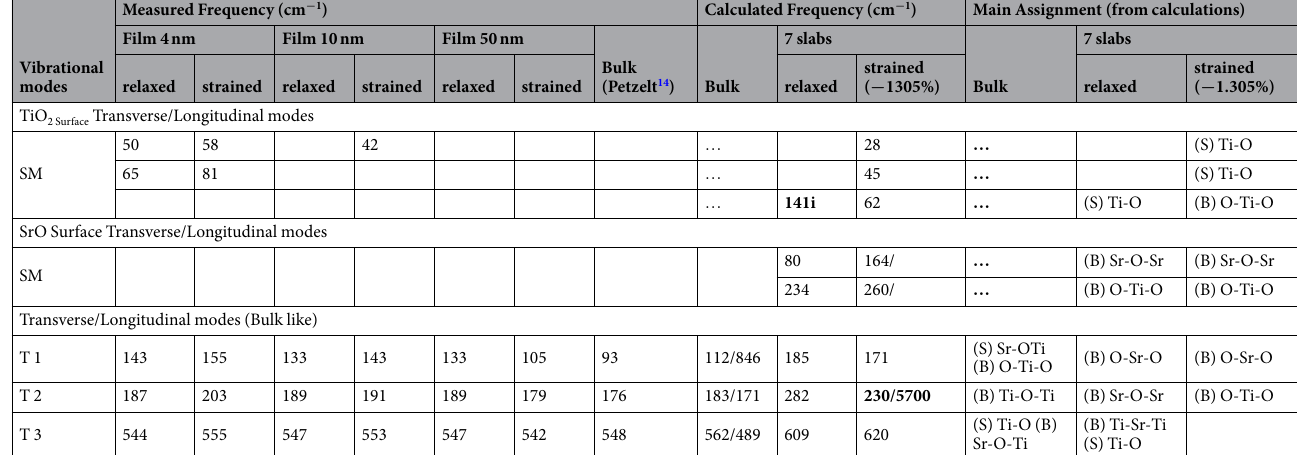
The unstrained and strained thickest films ( ∼ 50 nm) present the so-called TO 1 , TO 2 and TO 4 peaks as observed for bulk 13–15, 37 (See Table 1). For bulk modes, the assignments can be resumed as follows: TO 4 and TO 2 are Ti-O stretching and bending modes respectively, while the Sr-TiO 3 lattice vibration gives rise to TO 137 . Meanwhile, two weaker bands appear on the thinnest strained film at 58 and 81 cm − 1 and an intense band is clearly present on the strained 9 nm film at ~40 cm − 1 . In short, the strained thinner layers (5 and 9 nm) present phonons struc- tures shifted at higher frequency and extra phonon at low frequency (probably due to surface modes) compared to bulk or to thicker relaxed films. Figure 1c presents the calculated phonon structures for bulk (bottom), and unstrained slabs of 7, 5 and 3 STO layers ( ∼ 2.5, 2.0 and 1.2 nm respectively). Note that the 7 layers film presents to the slab makes the calculations of IR spectra extremely CPU time consuming. The simulated spectra show an excellent agreement with measurements for bulk 13–15, 37 as well as for the thicker films (See Fig. 1a and b and Table 1). Certainly, in terms of phonon positions and relative intensities both experimental and simulated spectra include three phonon structures, two weaker around 200 cm − 1 and 550–600 cm − 1 and a stronger one around 100 cm − 1 . Indeed, the numerous modes for the various slabs result from the appearance of surface modes. It is worth highlighting that the calculated spectra of free slabs exhibit an intense imaginary mode ( ∼ 140i), showing that unstrained slabs are metastable. Figure 1d presents equivalent calculations on slabs of the same thickness under − 1.69% strain. Notice that imaginary modes of Fig. 1c are no longer present in the calculated spectra showing that strain has stabilized these slabs. Compared to relaxed slabs, the main spectral features appear quali- tatively in the same energy range but intense phonons are present at low frequencies. Most peaks, under 400 cm − 1 , result from the lowering of the symmetry of slabs compared to bulk which generates multiple components from TO 1 and TO 2 modes. This larger number of modes is in good agreement with the rich experimental 5 and 9 nm strained films spectra although none of the simulated spectra presents mode under 50 cm − 1 . Calculated spectra and dielectric constant of STO ultrathin films according to the strain. In the search for the conditions for developing a soft mode (and the FE state), we underwent systematic calculations on STO slab for various strain levels under − 1.69% (where no imaginary mode is observed) down to the occurrence of an imaginary mode. The results are presented in Fig. 2a for the slab of 7 layers (results for 3 and 5 layers show the same trend and are not shown here). This 7 layers slab corresponds to a thickness of 2.5 nm, a value of the same order as the 4 nm samples measured here, allowing therefore a qualitative comparison between the calcu- lated and measured spectra. Indeed, the lowering of the parallel strain from − 1.69% to − 1.305% causes a progressive modification of the sim- ulated spectra: the frequency of the SM mode tends to zero as the strain decreases down to − 1.305% and becomes imaginary for − 1.30%, while T1, T2 and T3 modes are independent of strain. Notice, however, that attempts to evaluate the spectra at intermediate strain failed because the structure oscillates between being stable and metastable.